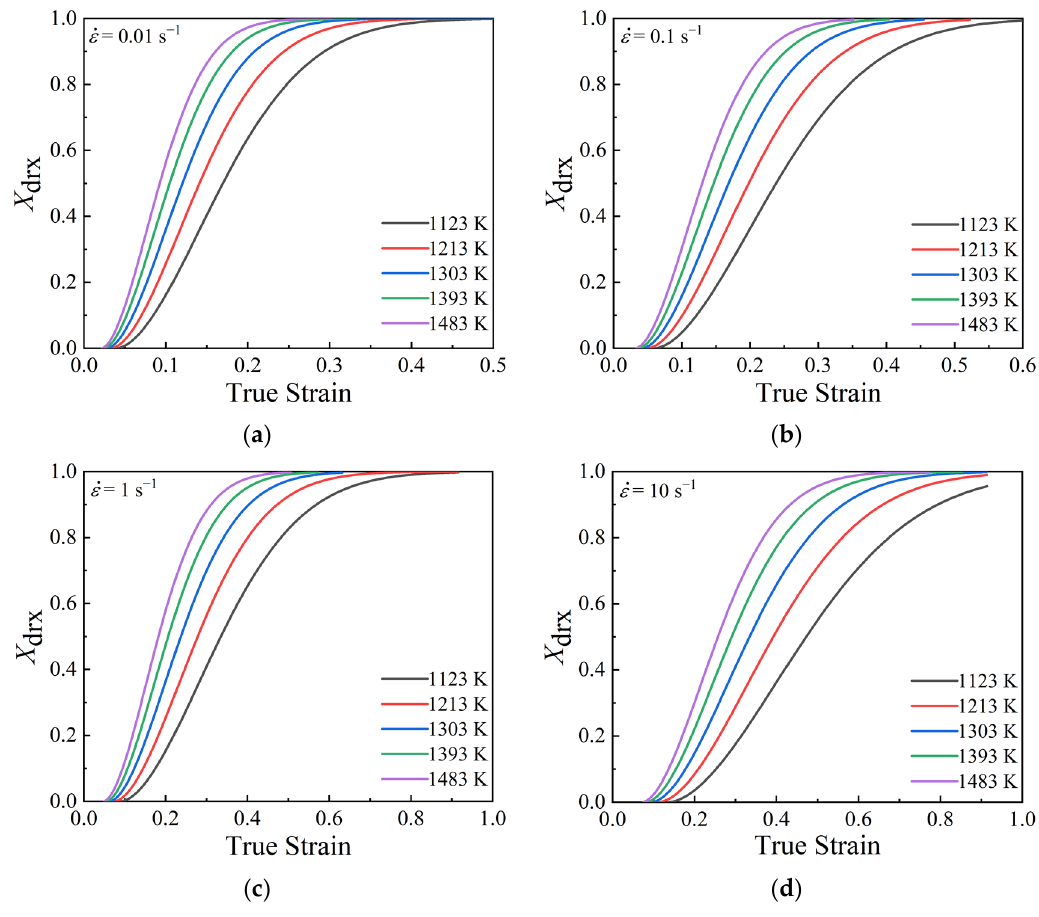
X under temperatures of 1123–1483 K and different strain rates: Figure 9. Curves of calculated drx Figure 9. Curves of calculated X drx under temperatures of 1123–1483 K and different strain